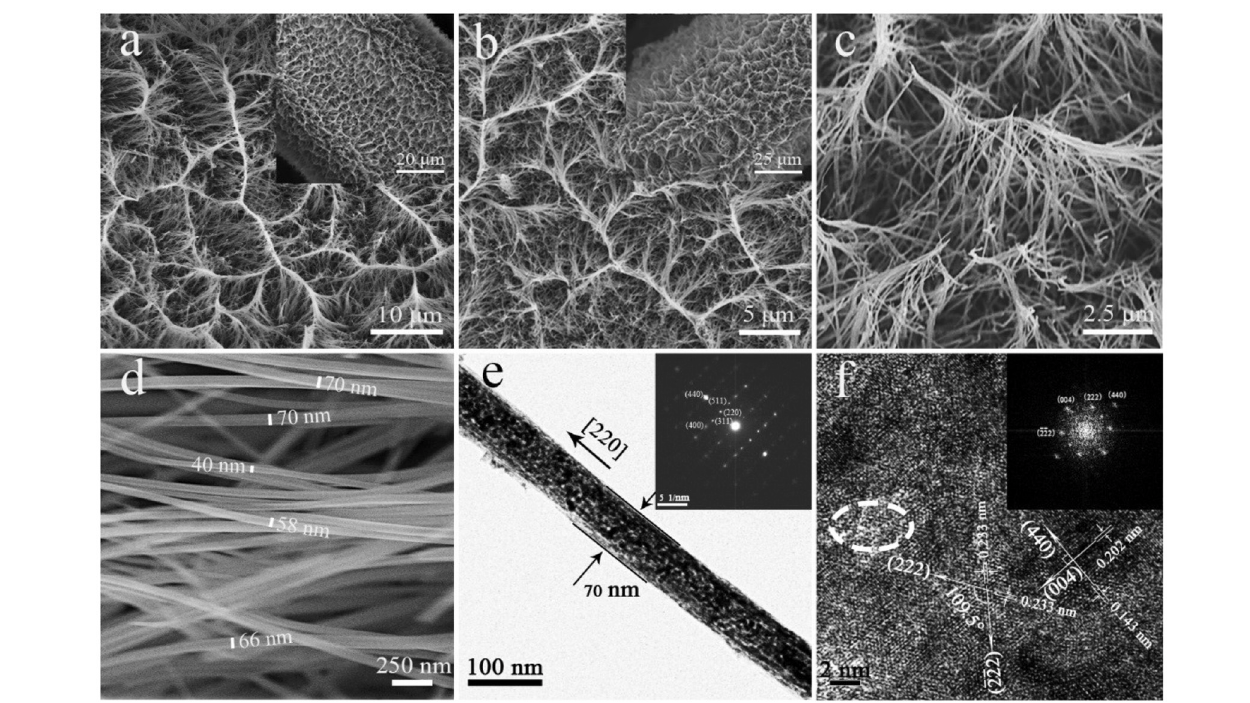
FIGURE 2 | (a) SEM images of precursor nanowire arrays on Ni foam, (b–d) SEM images of Co 3 O 4 NWAs on Ni foam at different magnifications, (e) TEM images (inset: SAED pattern) of Co 3 O 4 nanowires, (f) HRTEM image of Co 3 O 4 nanowires and corresponding FFT images (inset).